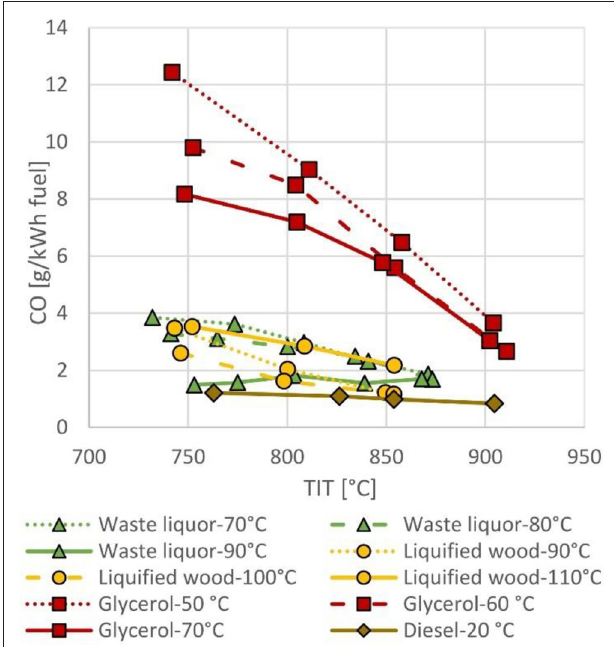
FIGURE 10 | CO emissions for different fuels at different fuel temperatures.